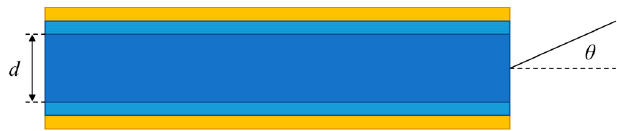
Figure 3. Geometry of the end of the sensor (Au-coated fibre): d = fibre core diameter; θ = maximum acceptance half-angle.